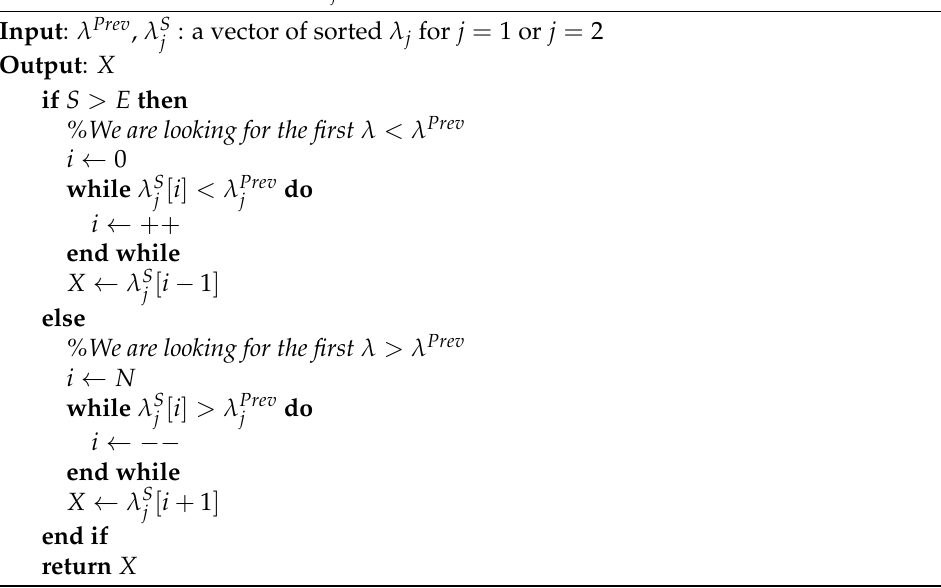
Algorithm A4 Function First λ S